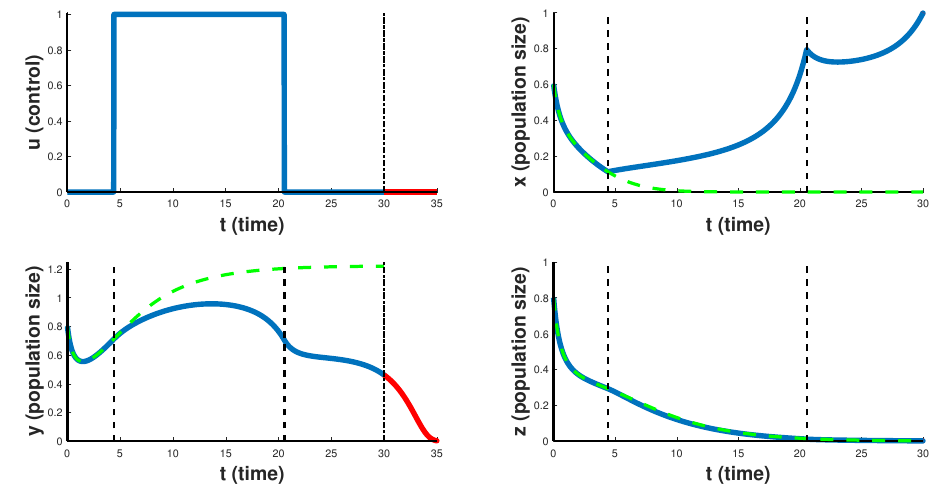
Figure 5. The optimal solutions x ∗ ( t ) , y ∗ ( t ) , z ∗ ( t ) and optimal control u ∗ ( t ) for the values of the parameters r = 0.6, p = 1.1, q = 1.0, η = 0.9, γ = 1.0, α 1 = 1.0, α 2 = 0.8, α 3 = 0.8, β 1 = 0.9, β 2 = 0.9, β 3 = 1.0, m = 0.5, µ = 50, u max = 1, T = 30 and the initial conditions x 0 = 0.6, y 0 = 0.8, z 0 =